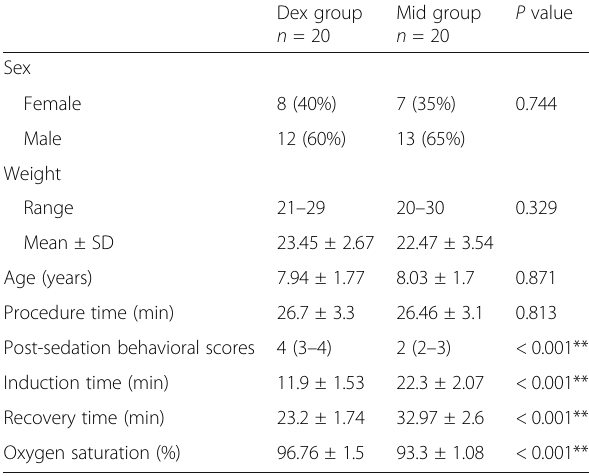
Table 1 Comparison of demographic data, procedural duration, post-sedation behavioral scores, induction time, recovery time, and oxygen saturation